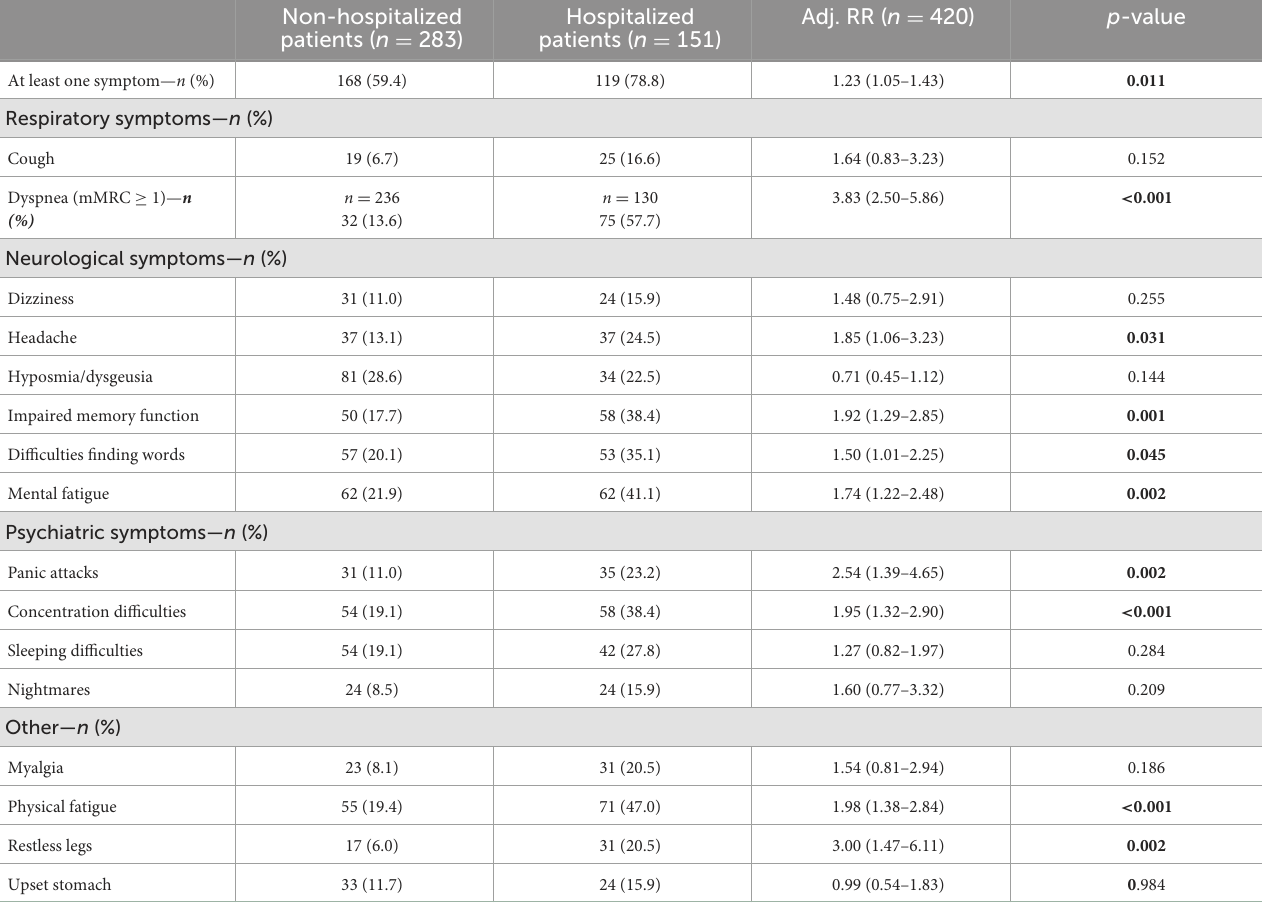
TABLE 2 Number of hospitalized and non-hospitalized patients (%) with different persistent symptoms. Non-hospitalized Hospitalized Adj. RR ( n = 420) p patients ( n = 283) patients ( n = 151)